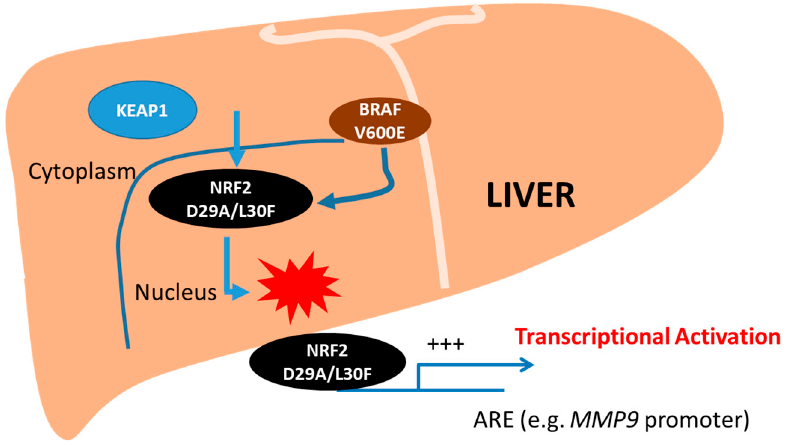
Figure 6. Graphical representation of mutant NRF2 transcriptional activity on target promoters. Novel human NRF2 MTs (D29A, L30F) disturb proper binding to KEAP1 and go to the nucleus, leading to an increase in transcriptional activity. BRAF V600E MT induces NRF2 MT transcriptional activity through increased MMP9 transcription. The increased transcriptional activity caused by NRF2-BRAF-MMP9 signaling may induce cell proliferation and invasion in liver tumors.